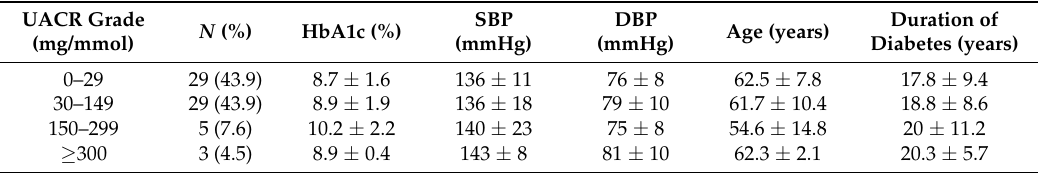
Table 3. Comparison of HbA1c, systolic blood pressure, diastolic blood pressure, age, and duration of diabetes between urine microalbuminuria (UACR) grades.